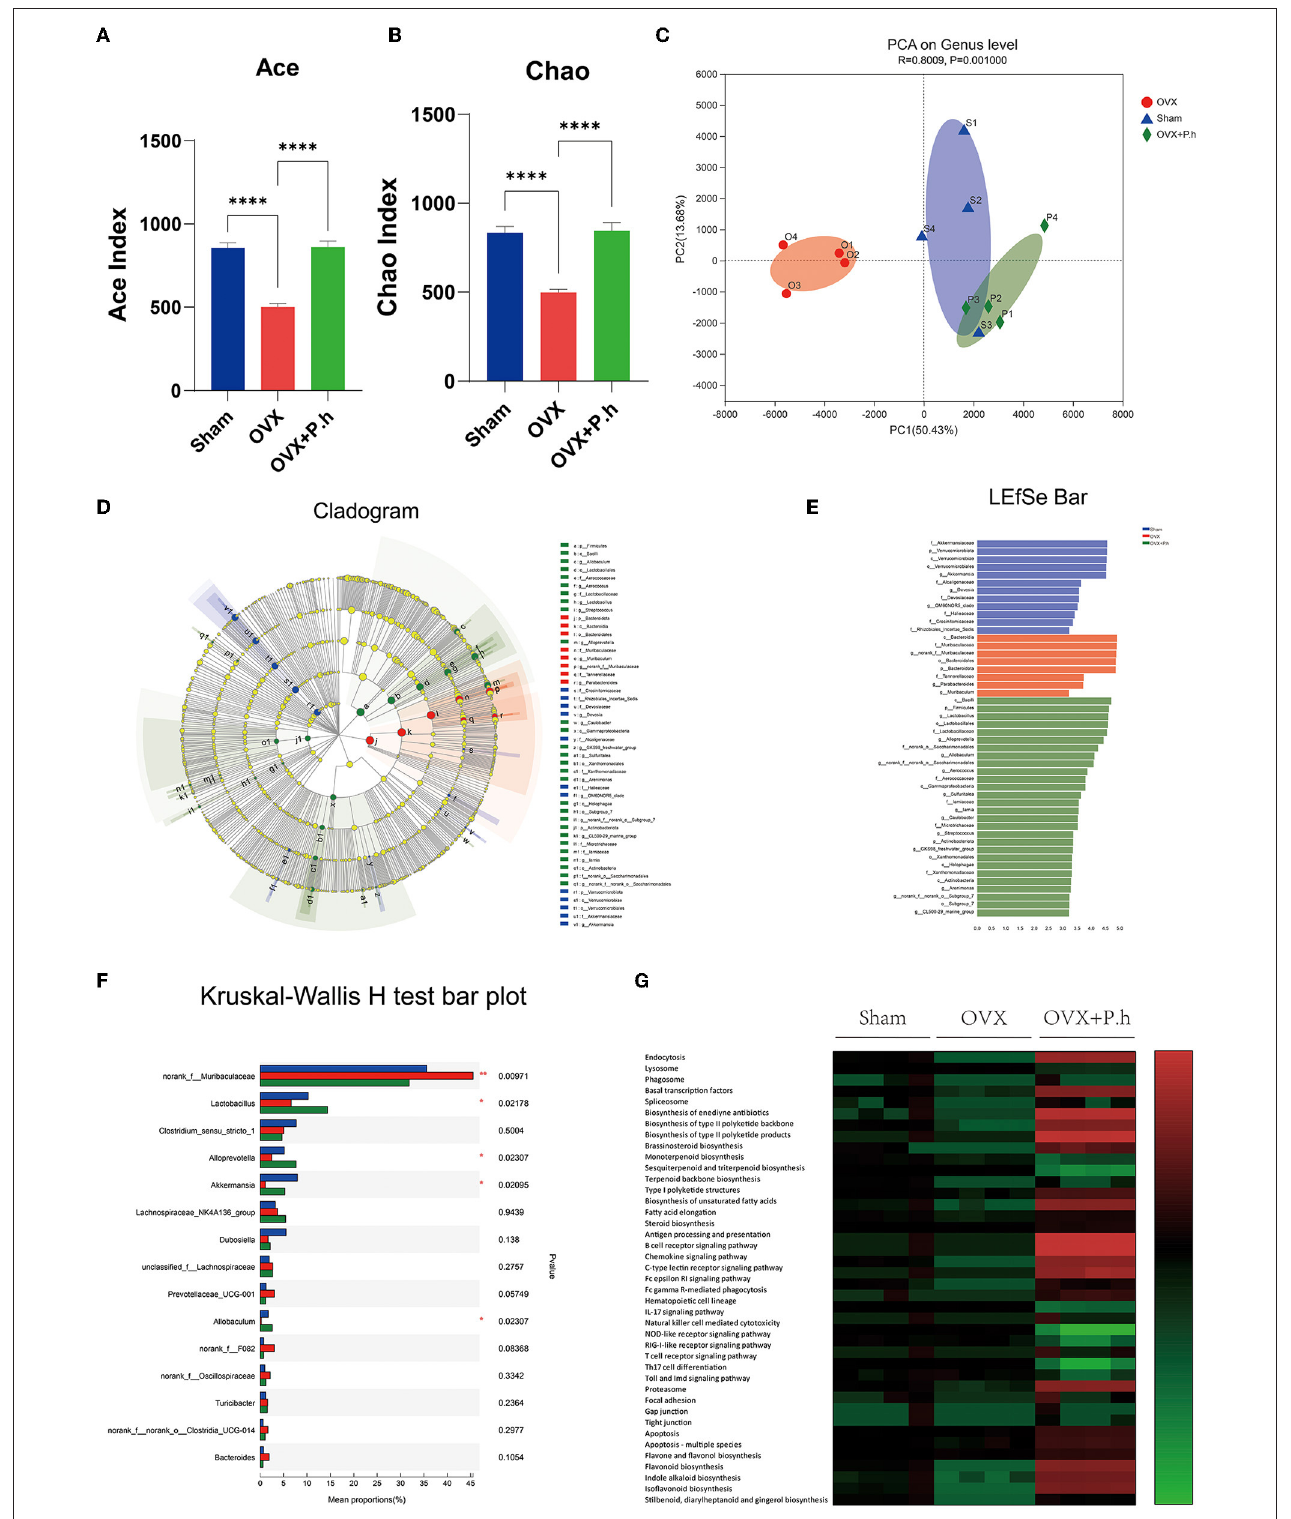
FIGURE 3 | P. histicola restored the intestinal flora disorder of OVX mice. (A,B) Alpha diversity index ACE (A) and Chao (B) . (C) PCA on gene level of beta diversity analysis. (D,E) LDA effect size analysis and LDA discrimination results of each level. (F) Intergroup difference test at genus level. (G) The KEGG metabolic pathways of PICRUSt2. Data are presented as means ± SEM ( n = 4/group). **** p < 0.0001.